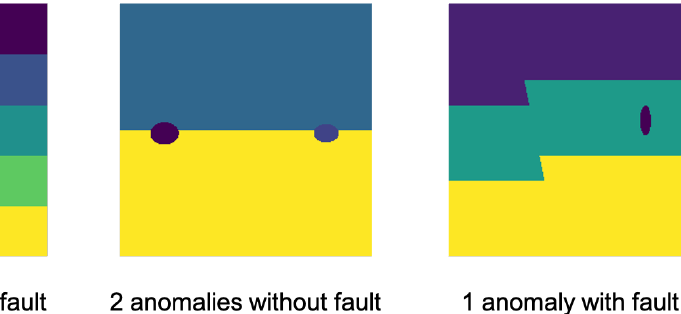
Figure 7. Examples of velocity